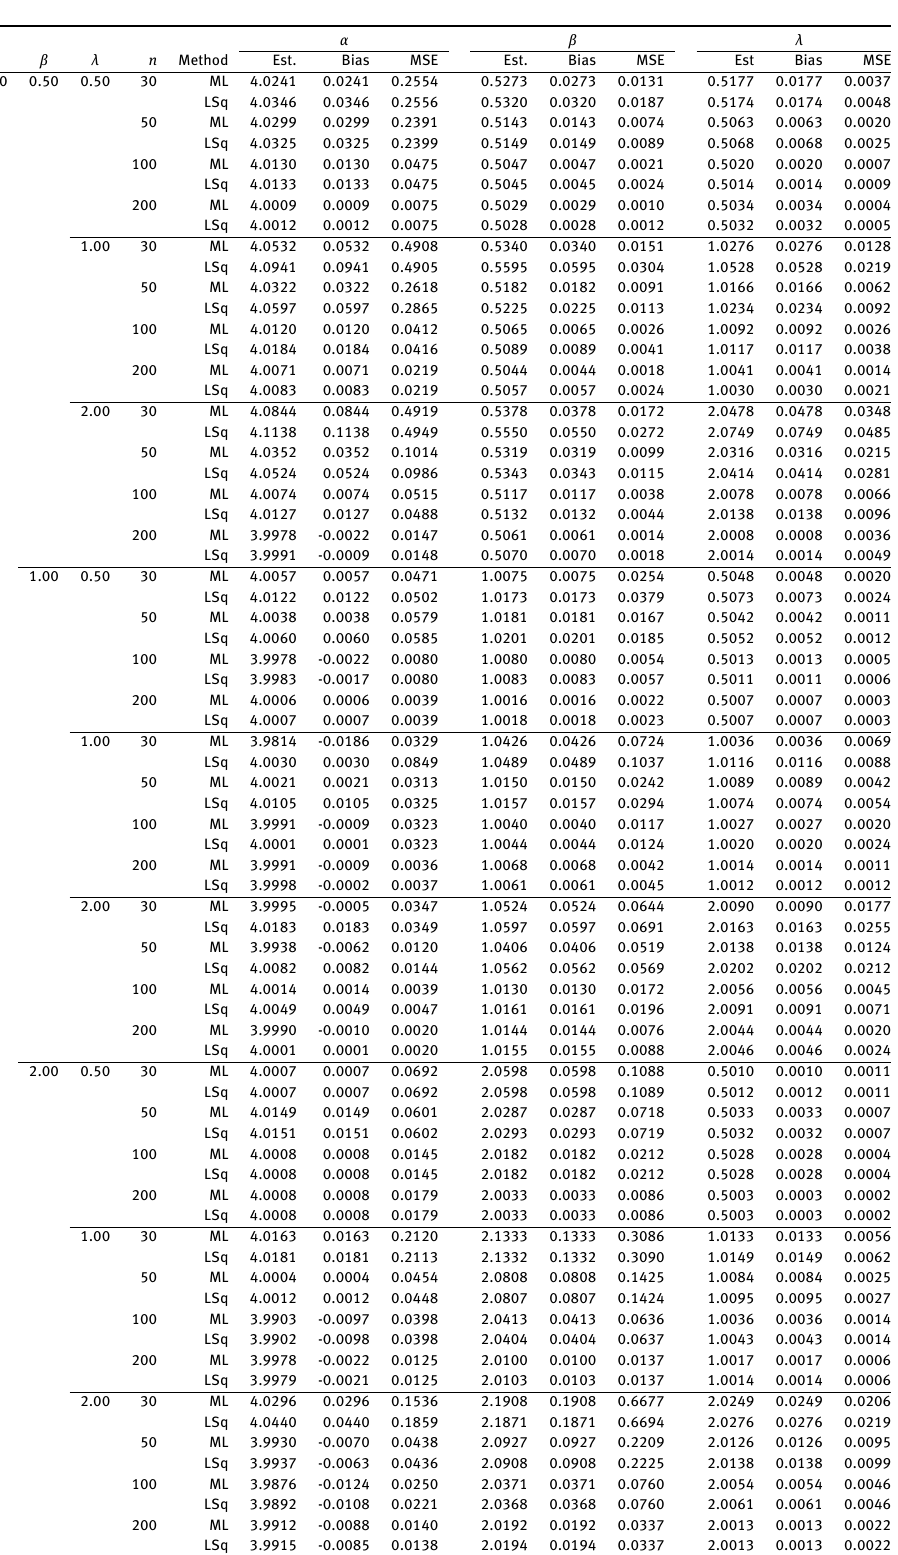
Table 2: Parameter estimates, Bias and MSE values, when α =